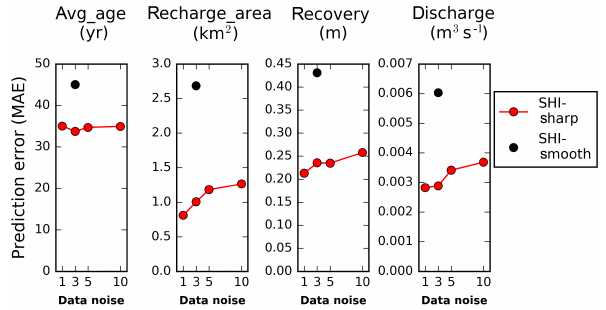
Figure 11. Prediction error as a function of the background noise on the geophysical data. The black dots are the SHI-smooth models using a background noise level of 3nVm − 2 . The red dots are the SHI-sharp models as a function of background noise